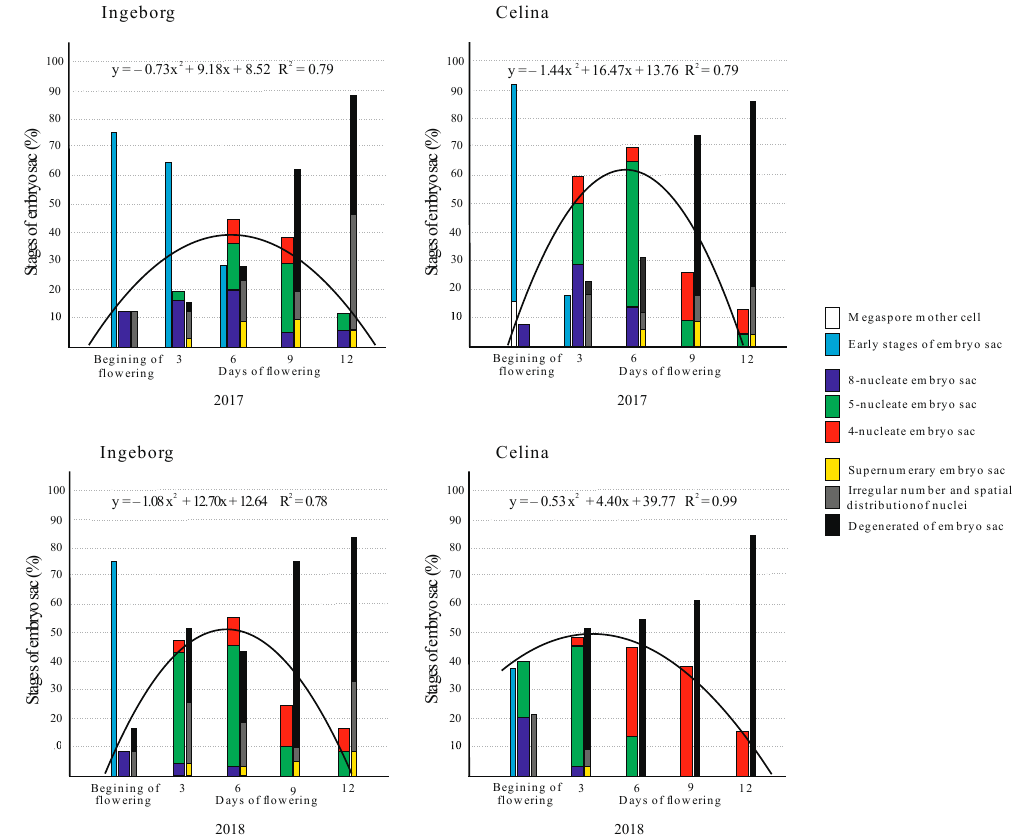
Figure 4. Regression analysis of regular embryo sac stages (%) and embryo sacs with different anomalies and degenerations (%) in unpollinated flowers at the BOF, and on the third, sixth, ninth and twelfth day after BOF in ‘Ingeborg‘ and ‘Celina‘ during 2017 and 2018.